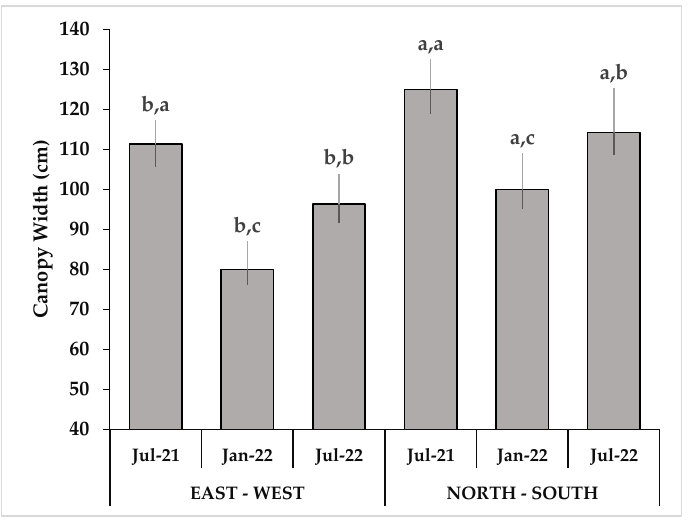
Figure 3. Tree width (cm) values in E – W and N – S orientations of a SHD almond orchard. First letters denote statistical differences between different row orientations; second letters denote statistical differences among different moments of observations ( p = 0.05; SNK test).